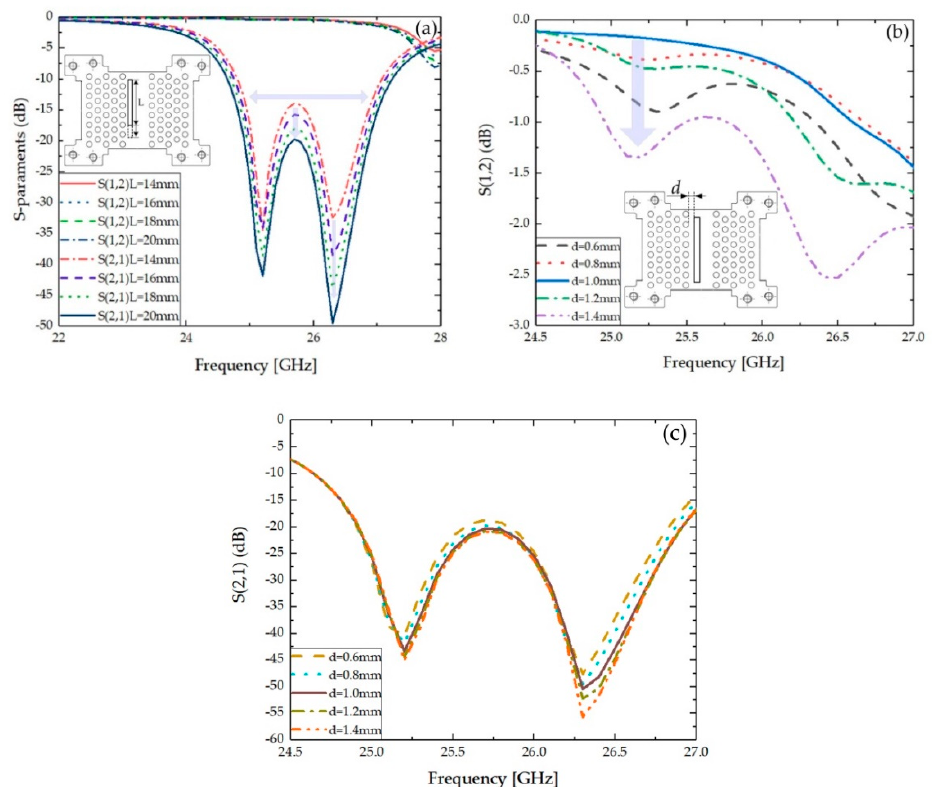
Figure 7. ( a ) The transmission characteristics of MO isolator change with frequency when the length L of ferrite sheets is 14, 16, 18, and 20 mm; ( b ) the transmission characteristics of MO isolator change with frequency when the distance d between ferrite sheets and the boundary of the PCW is 0.6, 0.8, 1, 1.2, and 1.4 mm; ( c ) and the isolations of MO isolator change with frequency when the distance d between ferrite sheets and the boundary of the PCW is 0.6, 0.8, 1, 1.2, and 1.4 mm.